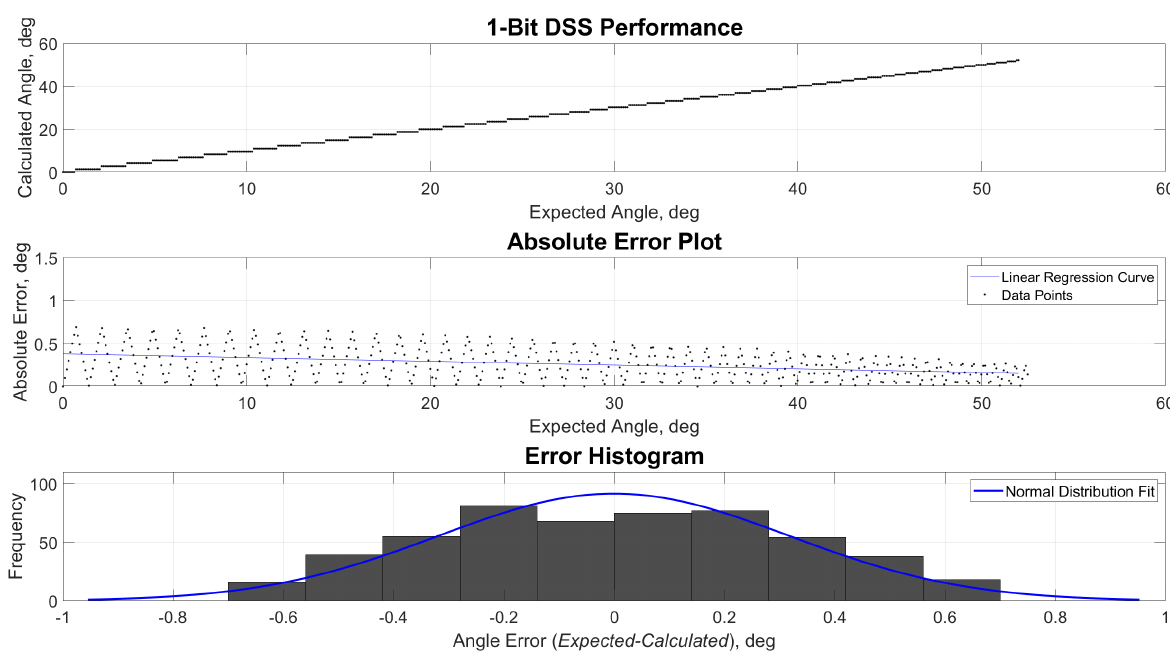
Figure 9. Performance, absolute error and error histogram plots for 1-bit readout mode.